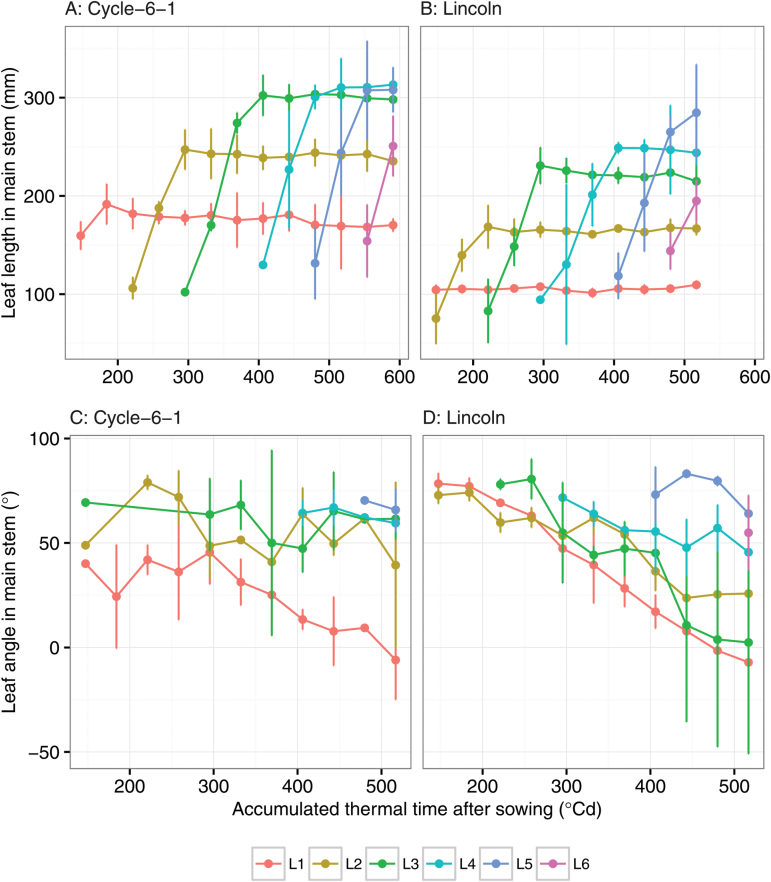
The dynamic growth of leaf length and leaf angle (degrees above horizontal) for leaf rank L1–L6 on the main stem for Cycle-6-1 and Lincoln. The leaf length is estimated from multiview images. The leaf angle is estimated from multiview images and defined as the angle between the vector from the base point to the middle point of the leaf midrib and the horizontal plane. The error bars indicate the standard deviation from three replicates. (This figure is available in colour at JXB online.)